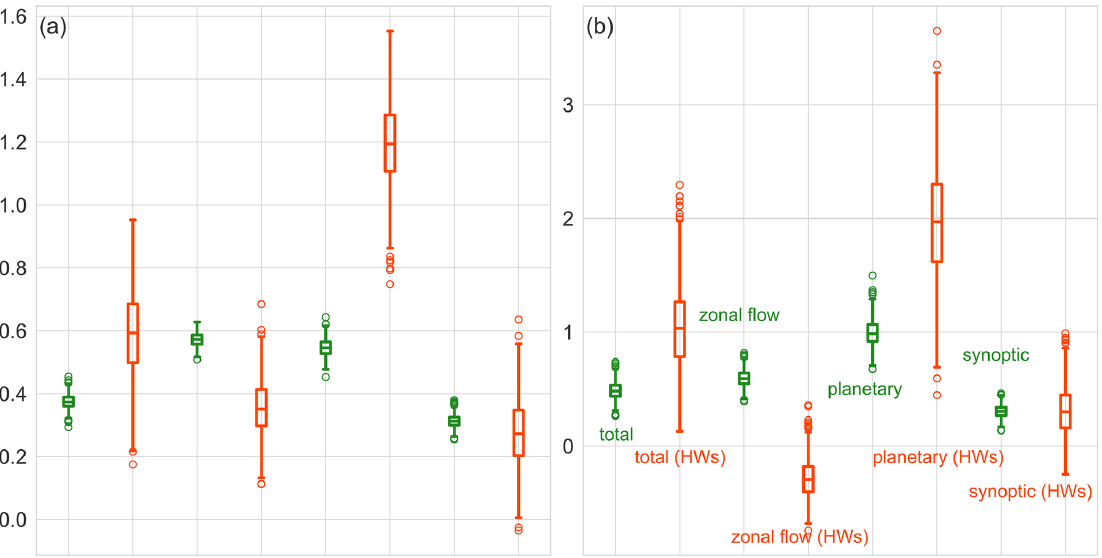
Figure 5. Box plots for the (a) skewness and (b) excess kurtosis of the PDFs of normalised energy anomalies for four circulation components: all Rossby modes (all k ), the zonal-mean flow ( k = 0), planetary-scale Rossby waves ( k = 1–3) and synoptic-scale Rossby waves ( k = 4–10). Vertical lines mark 95% confidence intervals. Green and red shades denote the climatology and HWs,